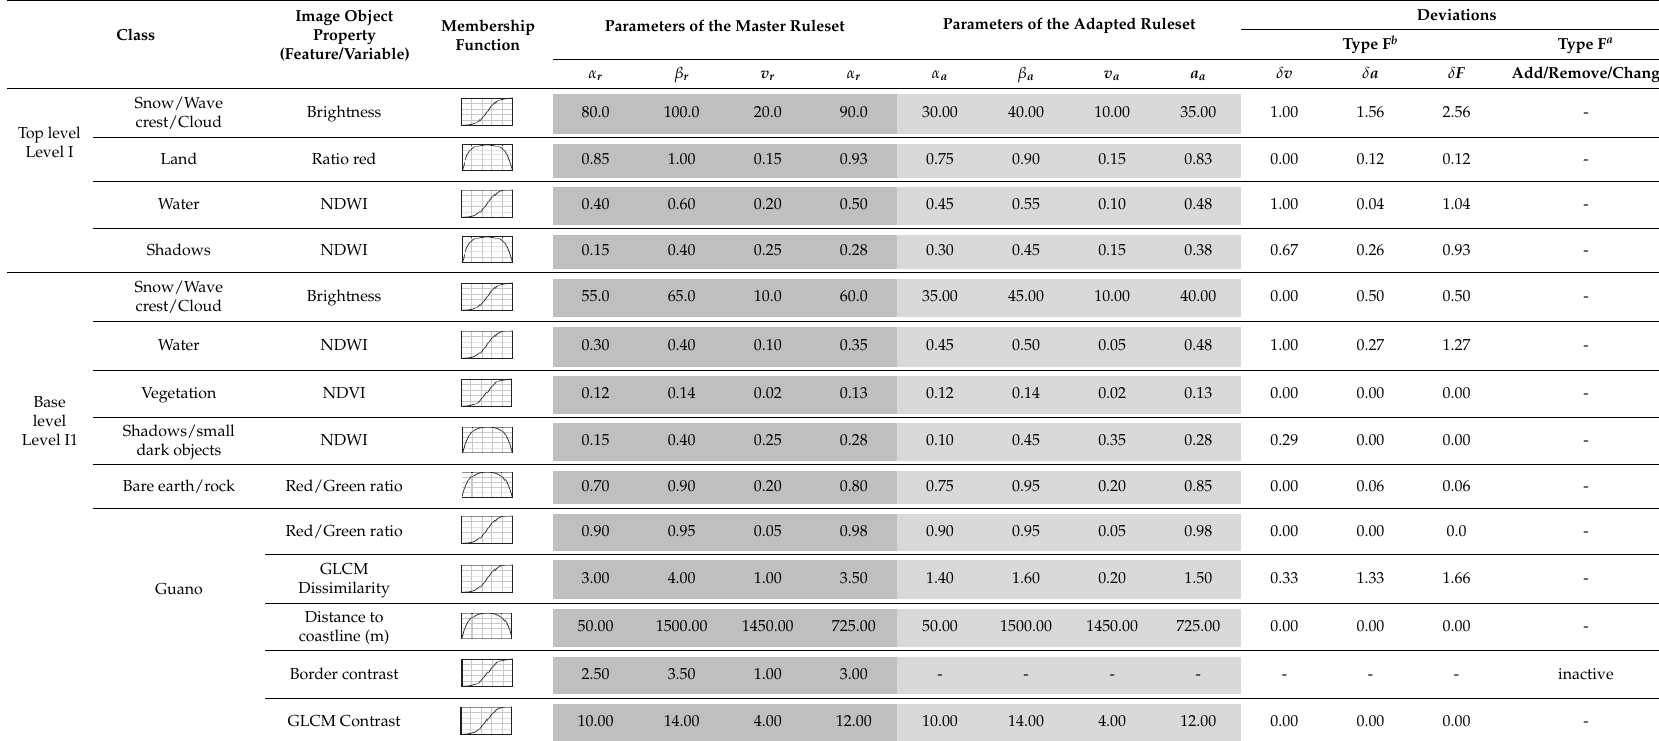
function describing property p : α —lower border, β —upper border, v —range, a —mean. Subscripts r and a denote reference ruleset and adapted ruleset,